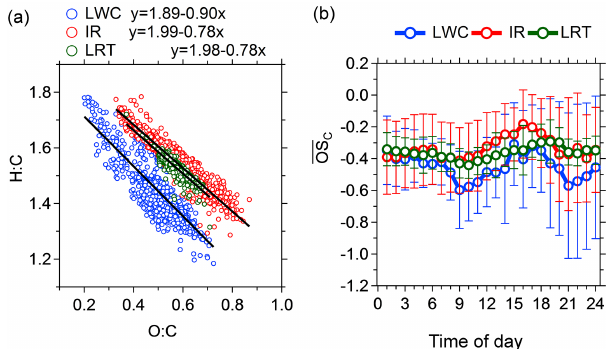
Figure 3. (a) Van Krevelen diagram for the three types of episodes and (b) diurnal variation in carbon oxidation state (OS c ). Means appear as circles with superimposed standard